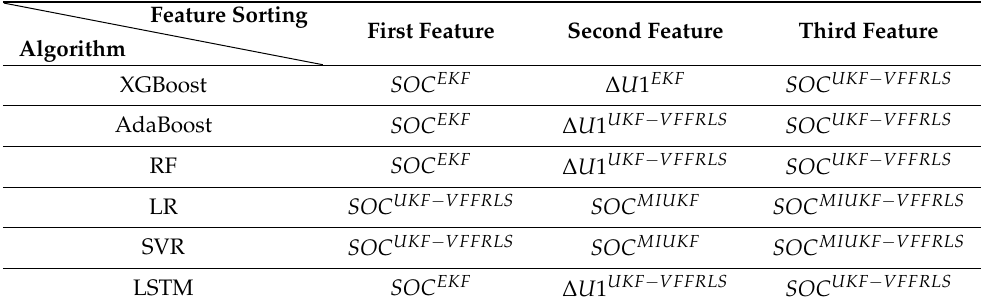
Table 1. The three most important features of each algorithm.